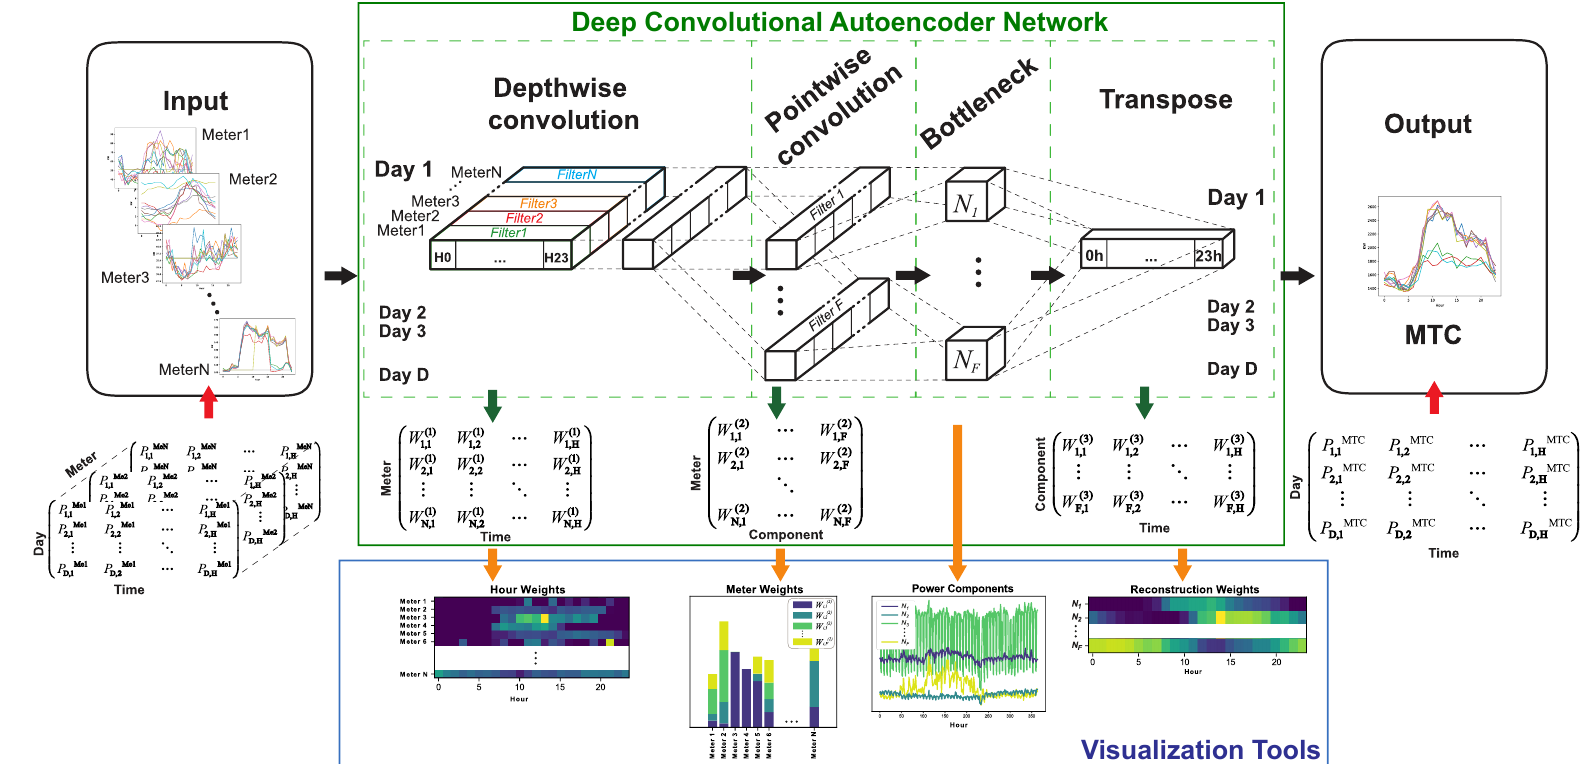
Figure 5. Feature extraction using a convolutional